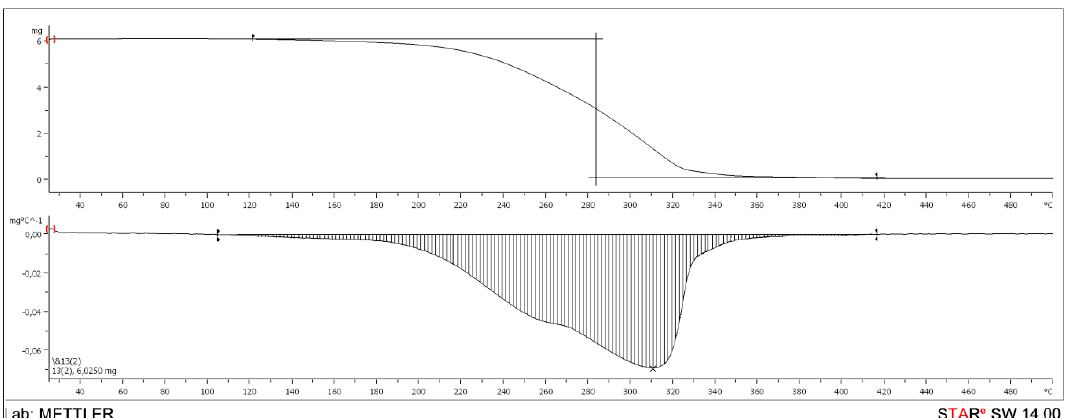
Figure 1. Figure 1. The thermal stability of the plasticizer of BEPEA by thermogravimetry, using a TGA-DSC-combined thermal analysis instrument.